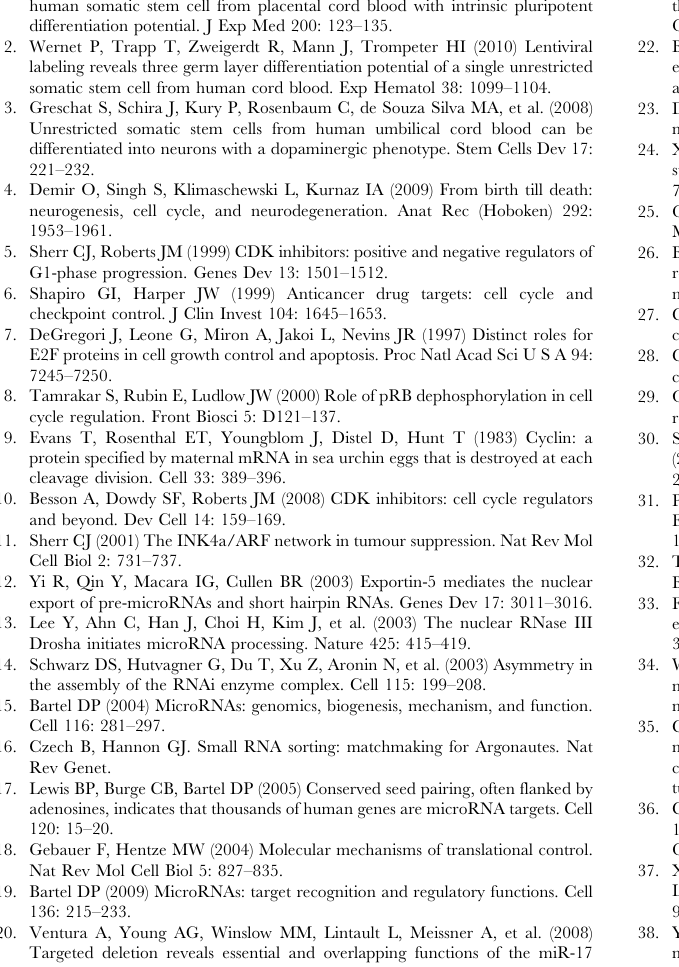
Table S1 Overview of cloned 3 9 -UTRs. A summary of Gene Bank accession numbers, PCR-primers, lengths of 3 9 -UTRs and cloned fragments thereof used for validations of predicted target genes is given. Restriction enzyme recognition sites are denoted in bold